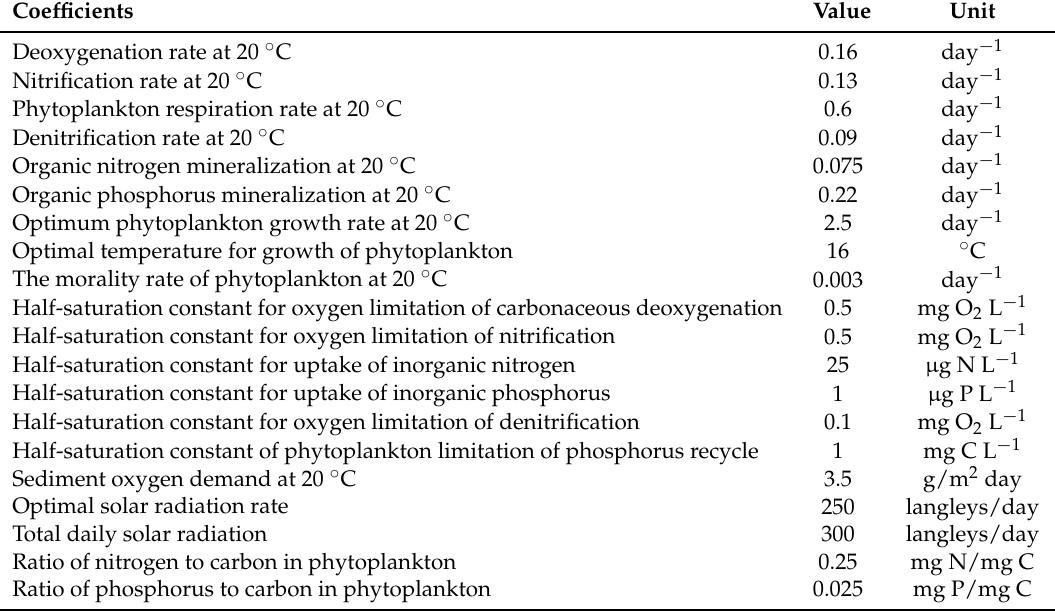
Table 1. Coefficients used in the water quality